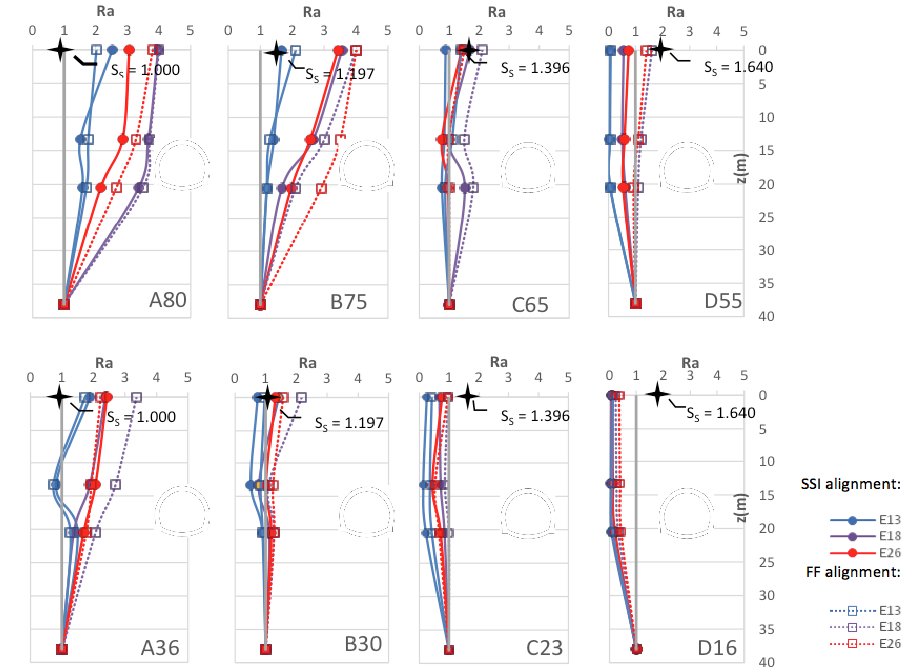
Figure 3. Comparison between amplification ratios in the symmetry axis of the building and of the tunnel (SS) and free-field conditions (FF) alignments for the eight models studied in the equivalent visco-linear elastic analyses.